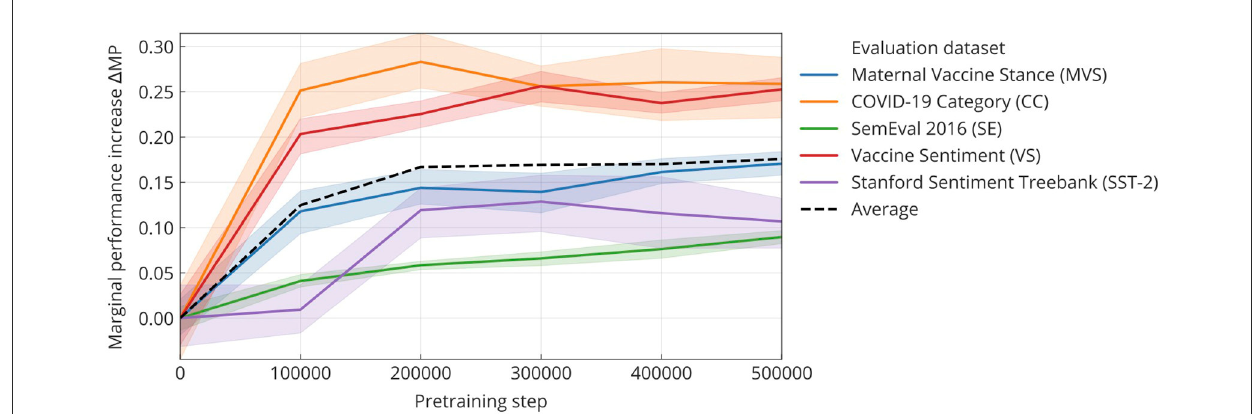
FIGURE2 Marginal performance increase in the F1 score ( 1 MP) on finetuning on various classification tasks at increasing steps of pretraining. Zero on the x-axis corresponds to the base model, which is BERT-LARGE in this case. Our model improves on all evaluated datasets, with the biggest relative improvement being in the COVID-19 category dataset. The bands show the standard error of the mean (SEM) out of 10 repeats. From this we can √ also estimate the standard deviation SD SEM = ∗